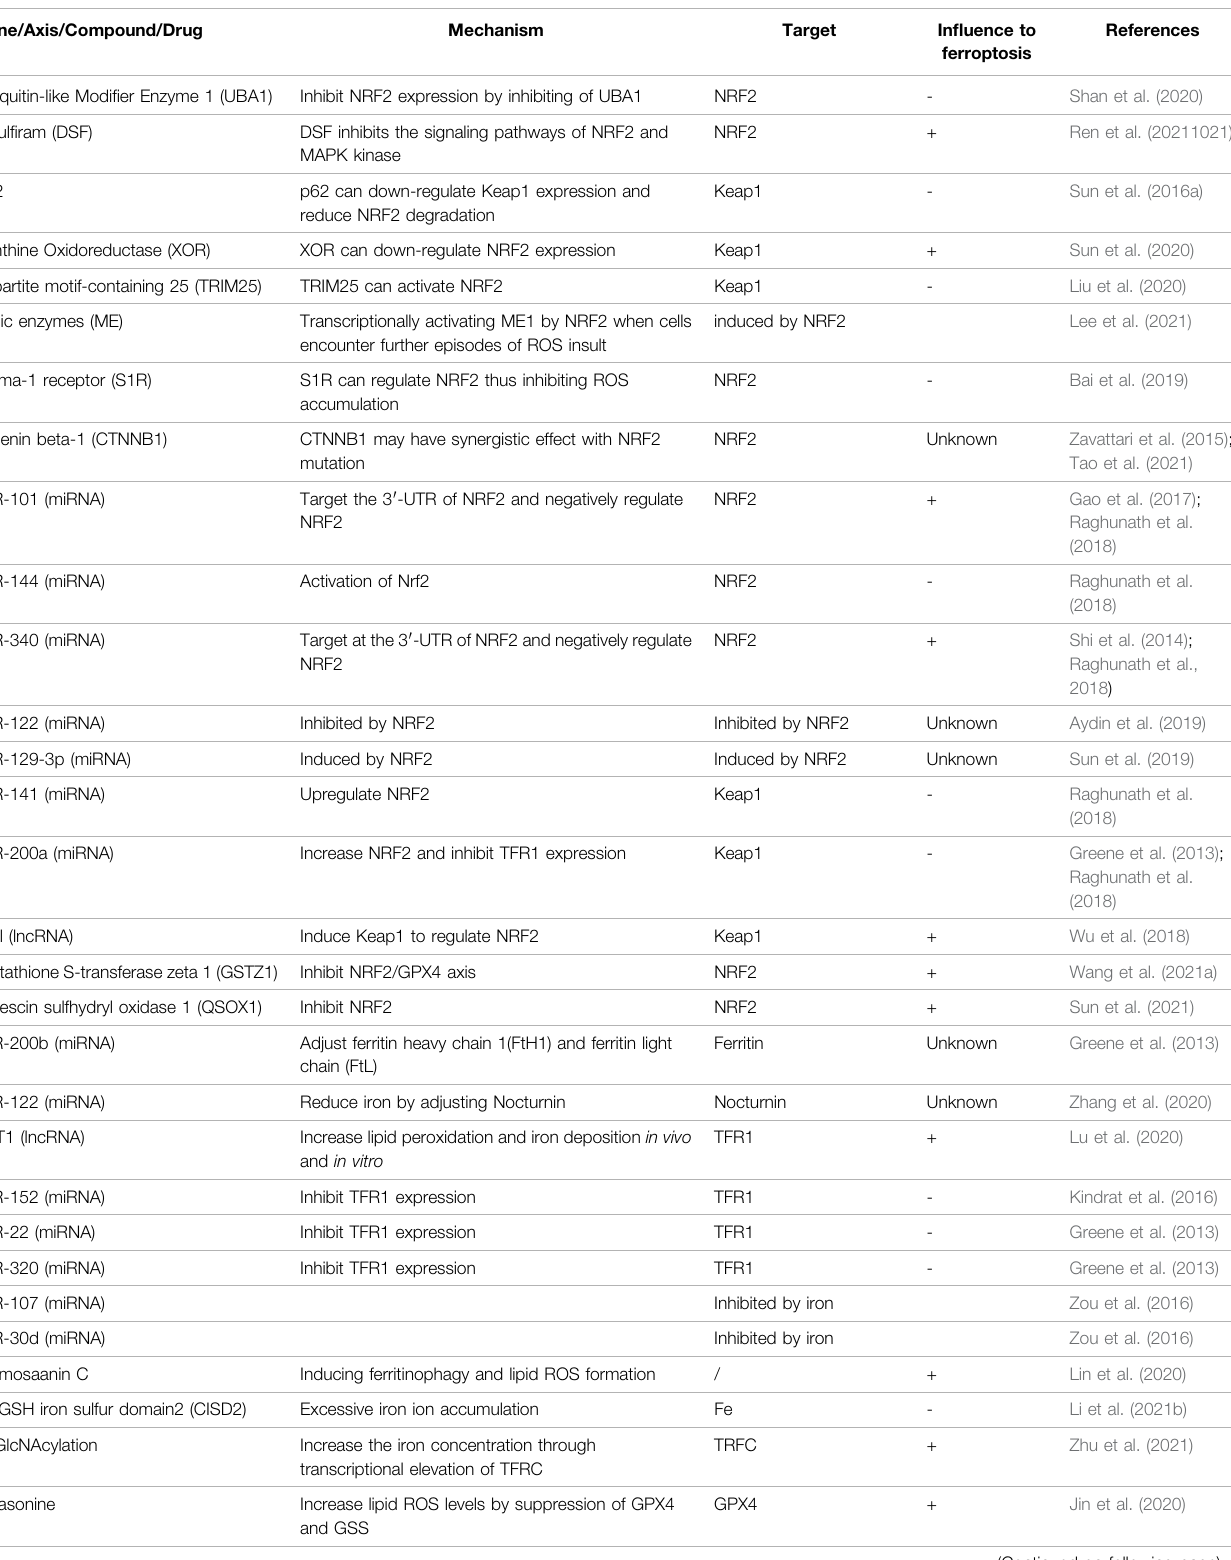
TABLE 1 | The regulators of ferroptosis in